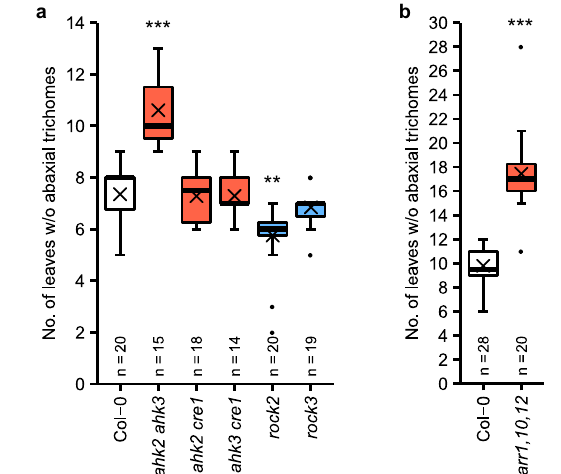
Fig. 2 The cytokinin-dependent regulation of the juvenile-to-adult phase transition is mediated by AHK2, AHK3, ARR1, ARR10, and ARR12. a , b Number of leaves without abaxial trichomes in cytokinin receptor mutants ( a ) and the type-B ARR mutant arr1,10,12 ( b ) grown in SD. In box plots, the center line represents the median value and the boundaries indicate the 25th percentile (upper) and the 75th percentile (lower). The X marks the mean value. Whiskers extend to the largest and smallest value, excluding outliers which are shown as dots. Asterisks indicate signi fi cant differences compared to the wild type of the respective experiment, as calculated by Kruskal – Wallis test ( a ) or Mann – Whitney test ( b ) (* p < 0.05; ** p < 0.01; *** p < 0.001). Exact p -values are included in the Source Data fi